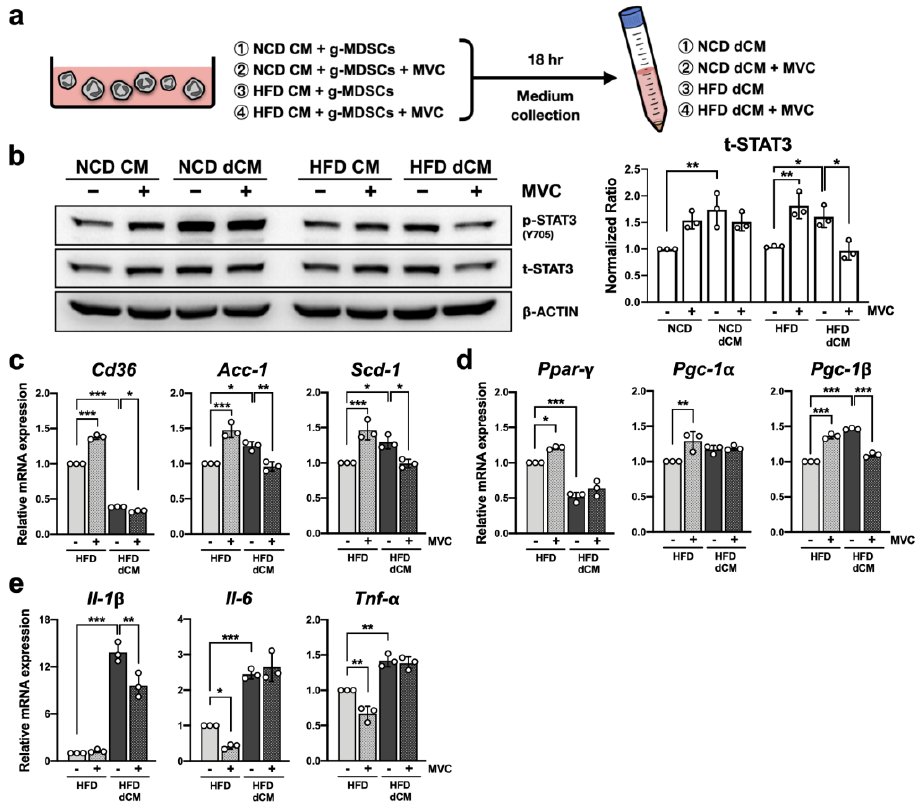
Figure 6. Blockade of g-MDSCs’ CCR5 signaling reduces STAT3 signaling and lipogenic gene expression in hepatocytes under the fatty liver microenvironment. ( a ) A schematic diagram of preparing g-MDSC-conditioned culture medium (doubly conditioned medium; dCM). ( b ) Primary WT hepatocytes were pretreated with 5 µ M MVC (+) or vehicle control ( − ) for 1 h and then stimulated with liver-CM or g-MDSC-dCM for 18 h. Total lysates were analyzed by immunoblotting to determine the status of STAT3 expression. The amount of total STAT3 was normalized to β -ACTIN and set the first group as 1 (n = 3). The levels of transcripts from genes related to hepatic lipogenesis ( c ), Ppar- γ with its co-activators ( d ), and pro-inflammatory cytokines ( e ) were determined by real-time PCR. Expression was normalized to the 36b4 reference gene and further normalized to the average value of the first group (n = 3). *, p < 0.05; **, p < 0.005; ***, p < 0.001.